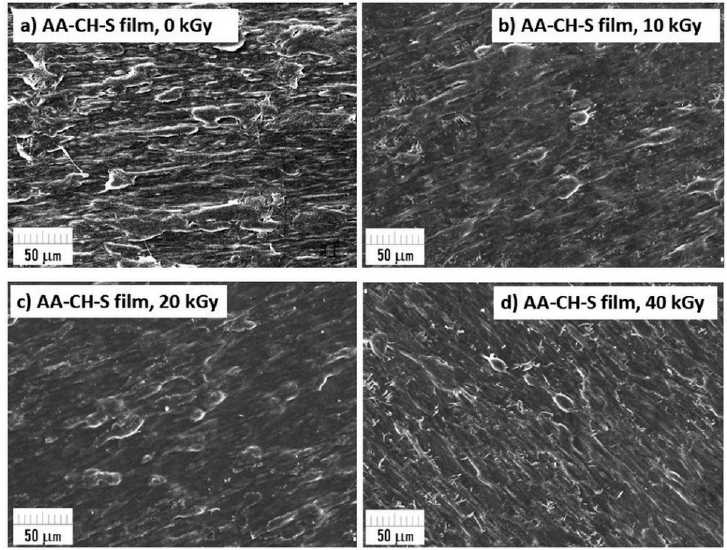
Figure 8. SEM micrographs of AA-CH-S films (0, 10, 20; 40 kGy) taken at 500× magnification.